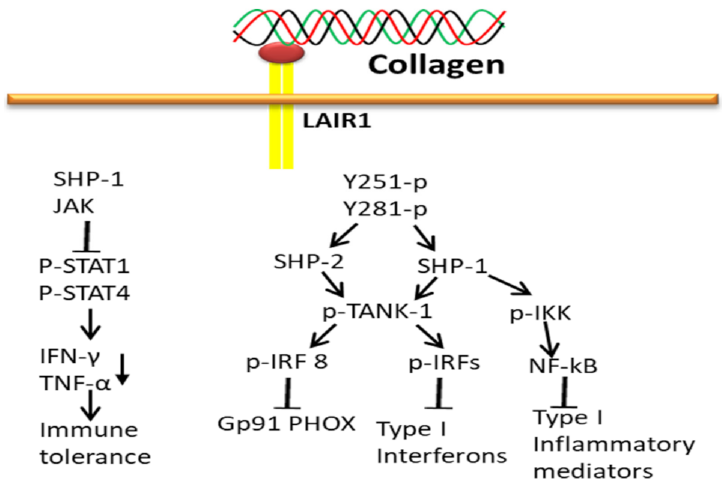
Figure 10. Collagen LAIR1 signals in immune